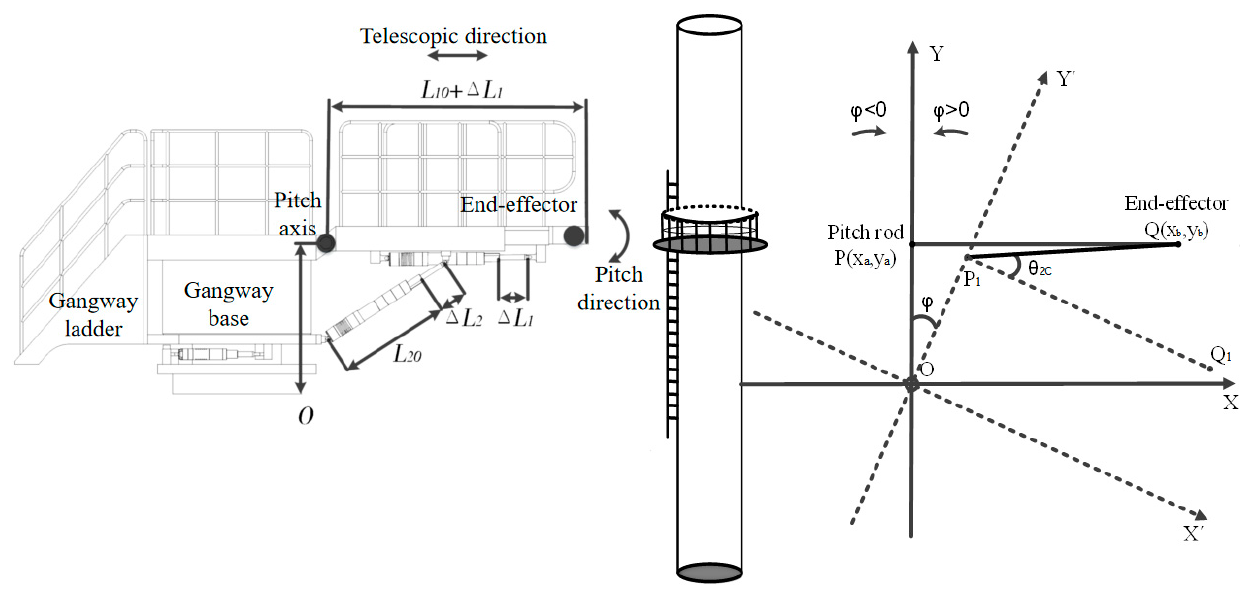
Figure 3. Gangway compensation ship rolling motion coordinate system.